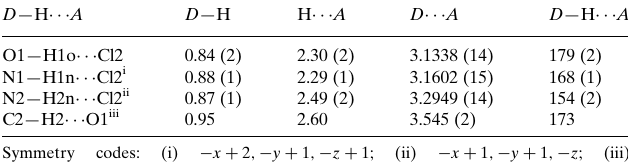
Hydrogen-bond geometry (A˚ , (cid:4)